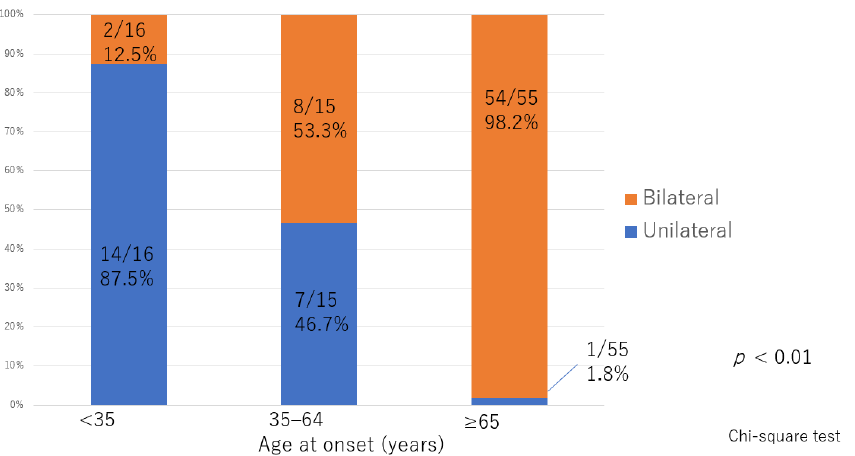
Figure 3. Distribution of laterality according to age of onset. The between group difference was statistically significant.